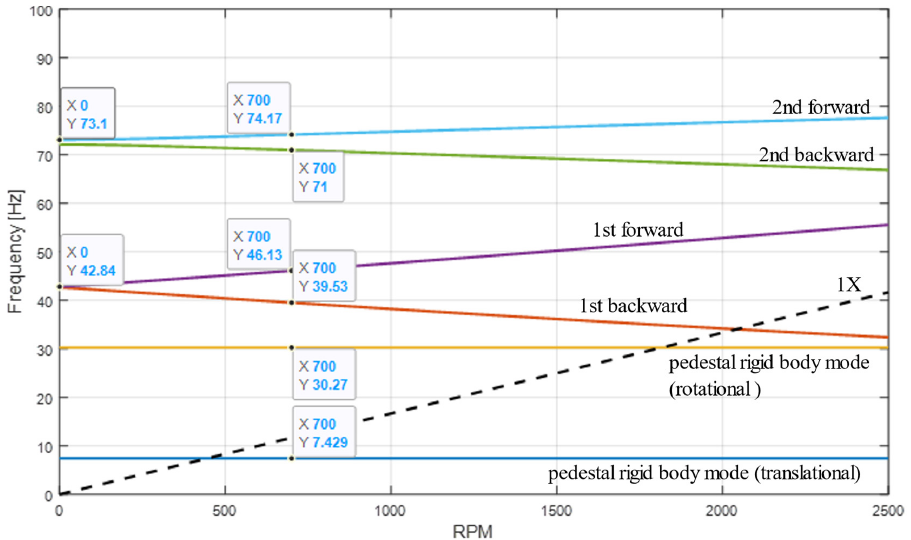
Figure 11. Campbell diagram. Table 4. Rotor and support model verification with the fem and measurement